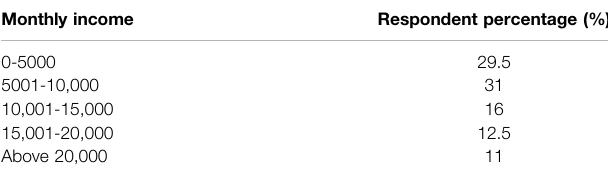
TABLE 5 | Levels of monthly household income.